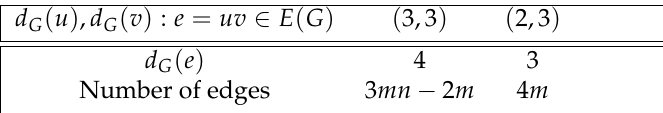
Table 2. dge degree partition of TUZC 6 [ m , n ] .